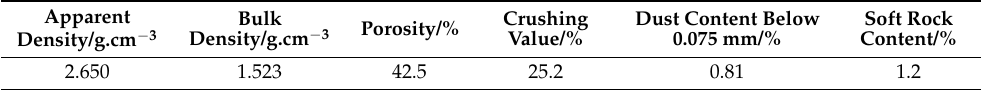
Table 5. Physical and mechanical properties of crushed stone coarse aggregate (wt.%).